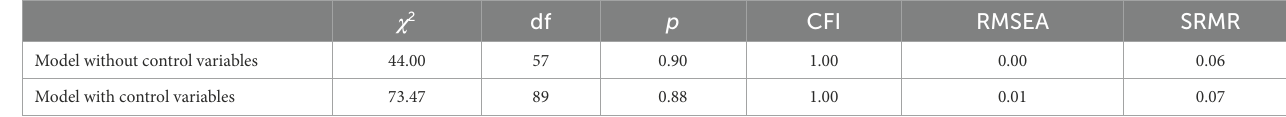
TABLE 4 Model fit indices of the structural equation models.